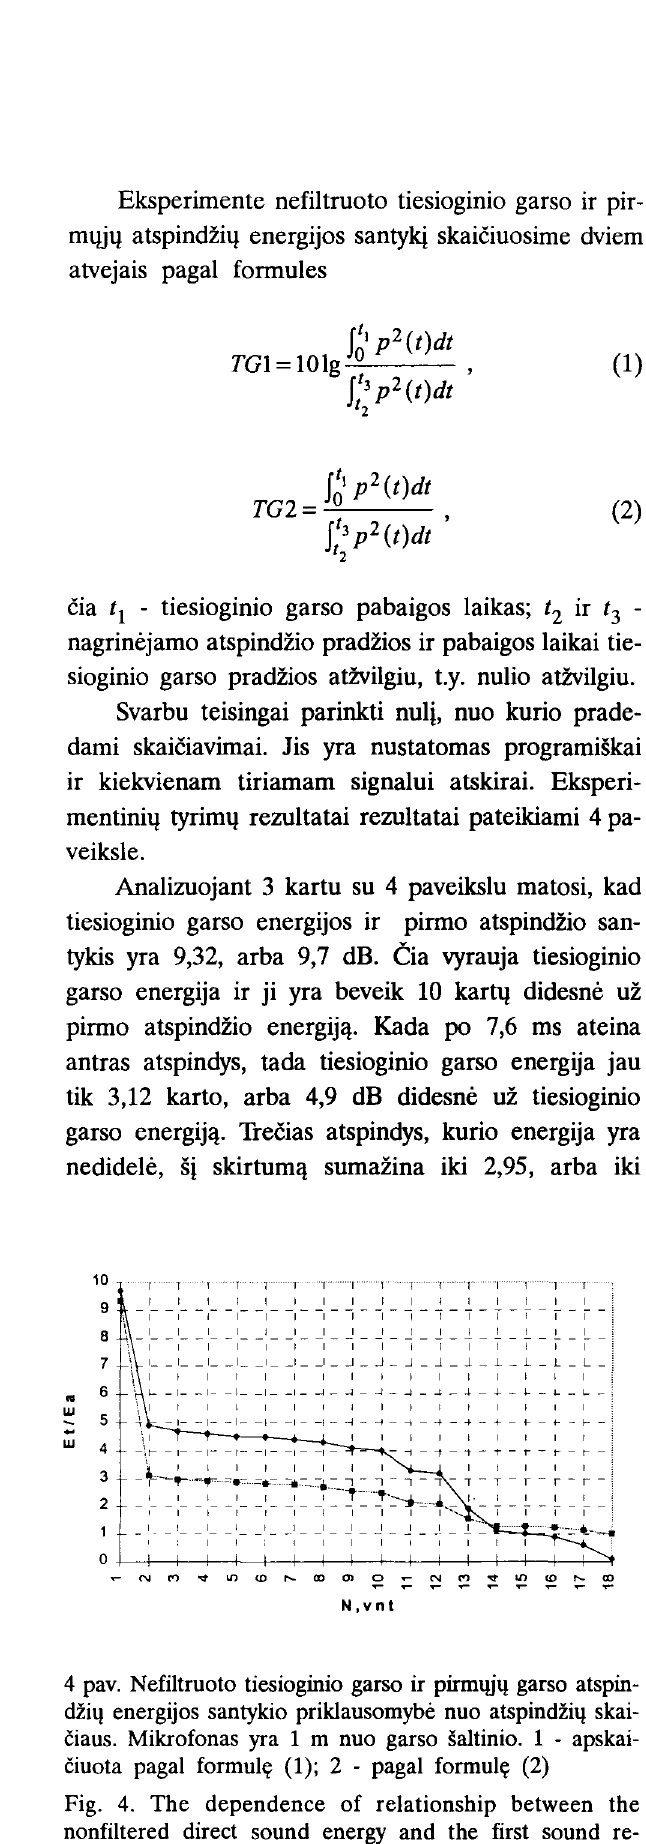
Ciuota pagal formuly (1); 2 - pagal formuly (2) Fig. 4. The dependence of relationship between the nonfiltered direct sound energy and the first sound re flection energy on the number of reflections. The micro phone is located 1 m from the sound source. 1 - com puted by formula (1); 2 by formula